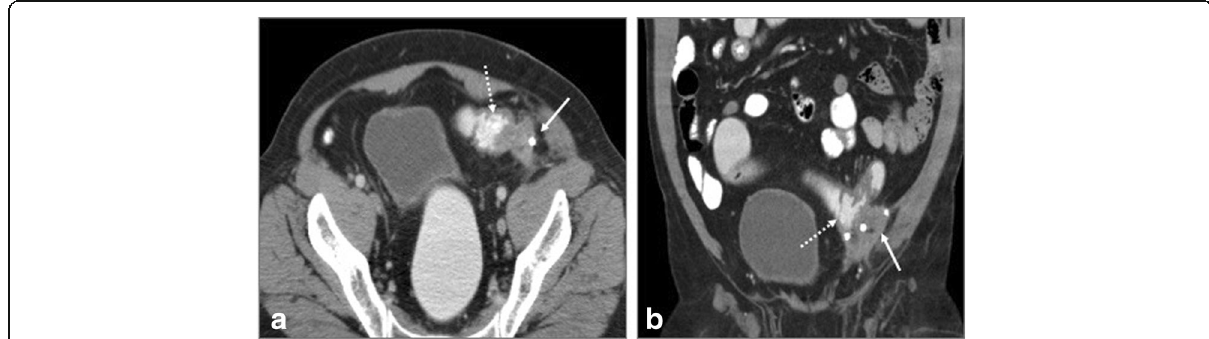
Fig. 11 Post left inguinal hernia repair. a , b CECT axial and coronal sections show migrated mesh (arrow) breaching the sigmoid colon (dashed arrow). Per operatively, contained perforation of the colon was seen with adhered mesh